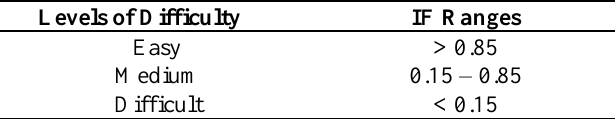
Table 1. Categories of Difficulty Level (Brown,